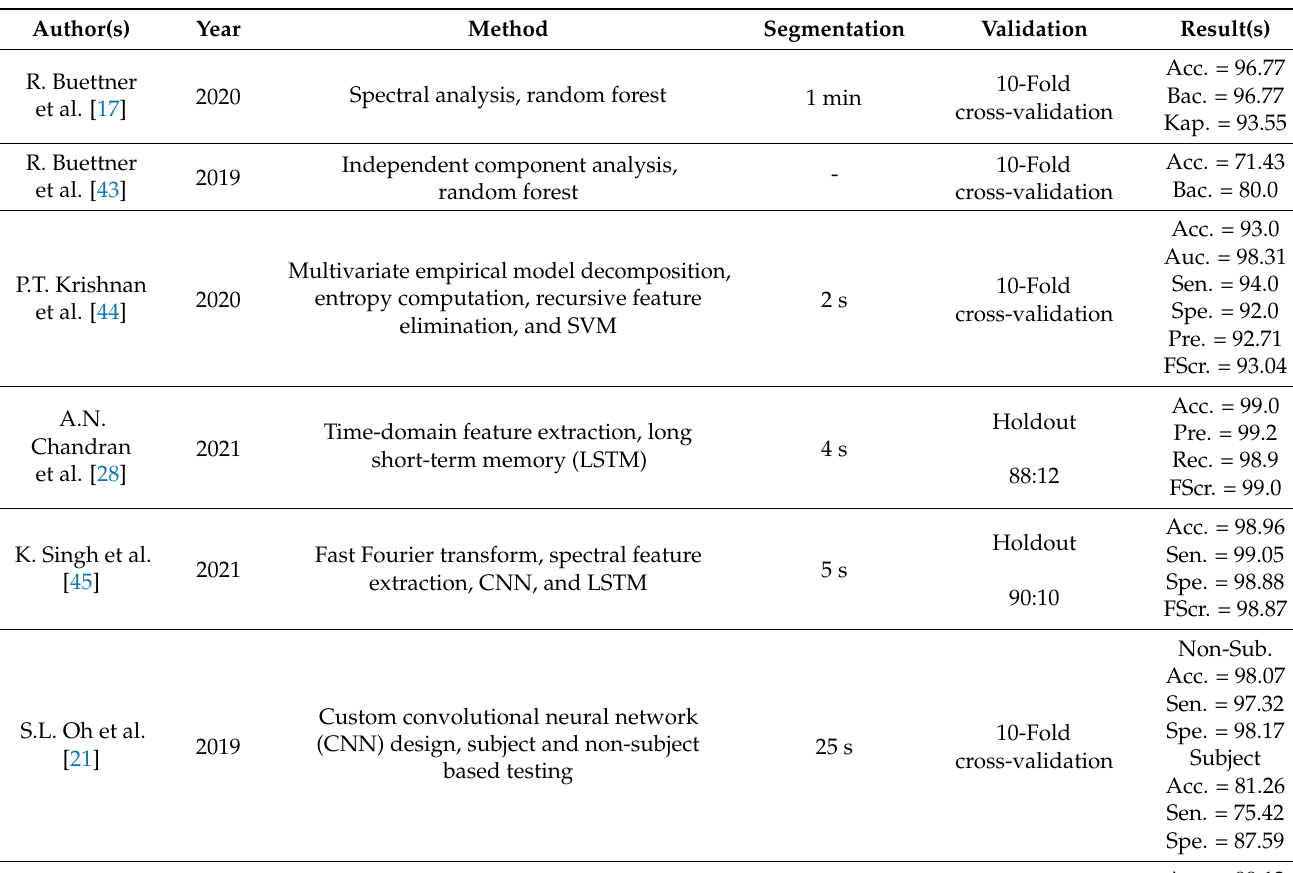
Table 8. Automatic schizophrenia classification based on EEG signals